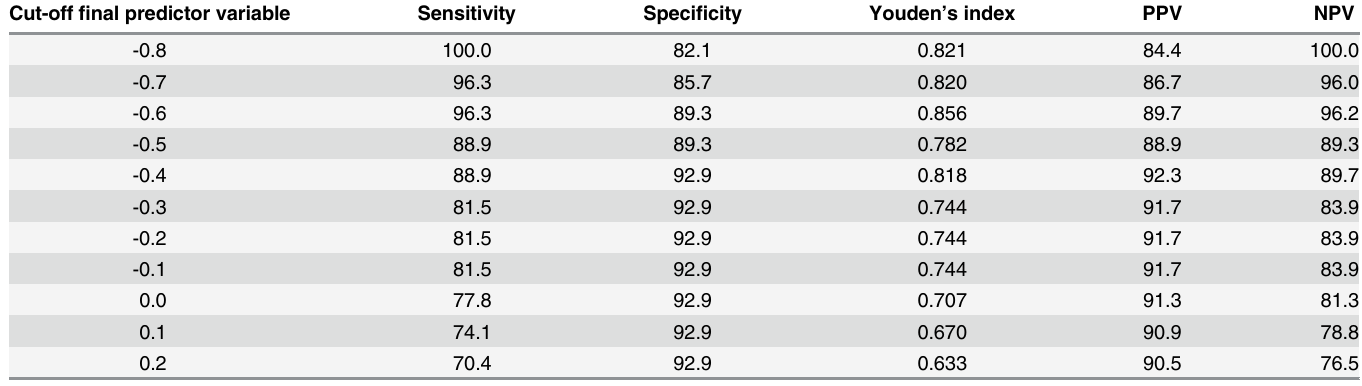
Table 5. Classification accuracy of the final predictor variable (including clinical interviews, neuropsychological assessment and driving simula- tor rides) in detecting patients being unfit to drive (n = 27) relative to patients being fit to drive (n = 28). Cut-off fi nal predictor